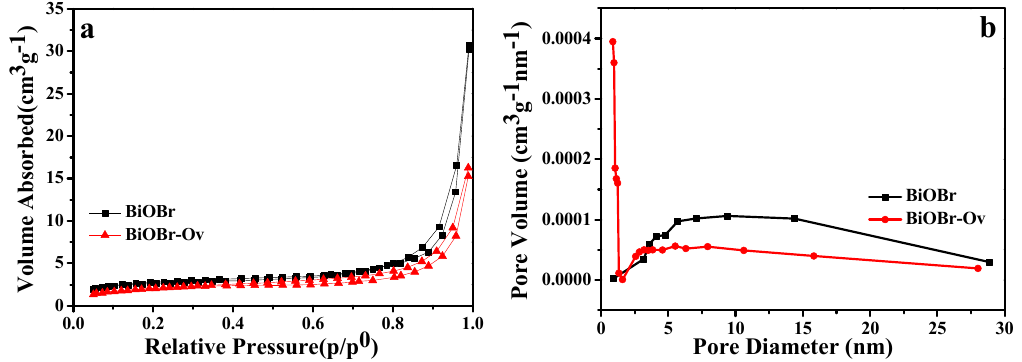
Figure 6. ( a ) Nitrogen adsorption–desorption isotherms and ( b ) the corresponding pore-size distributions of BiOBr and BiOBr-Ov.